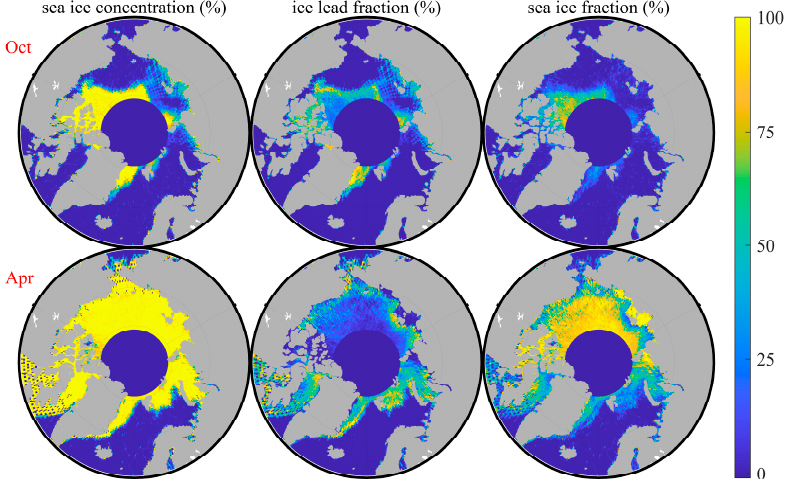
Figure 13. The sea ice concentration, sea ice fraction, and lead fraction based on the classification of the Bagging classifier from April and October 2019.